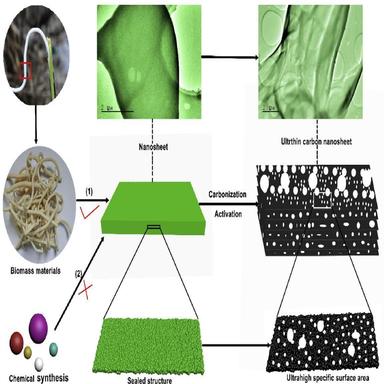
The schematic of synthesis of carbon nanosheets. (A colour version of this figure can be viewed online.)